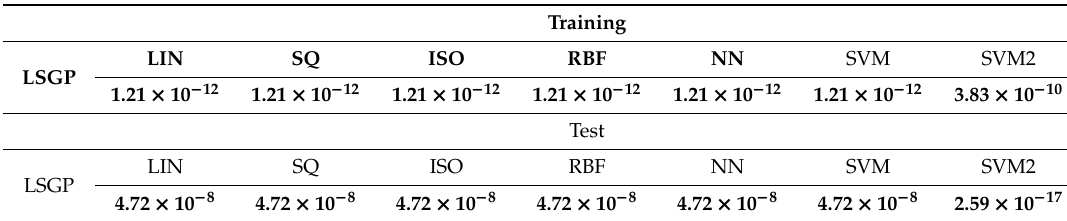
Table 3. P-values returned by the Mann–Whitney test under the alternative hypothesis that the samples do not have equal medians. In particular, the test compared the median MAE obtained by the considered techniques over the 100 runs we performed. Bold denotes values indicating a statistical di ff erence among the considered